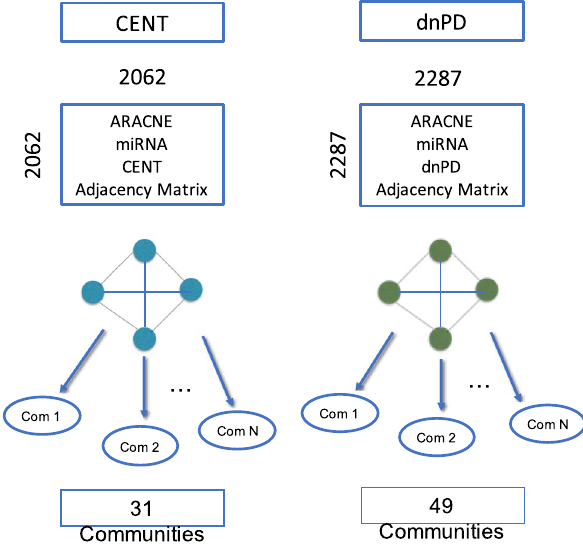
Figure 2. Network analysis. Graphical process of the network analysis implemented for the two cohorts of dnPDs and CENT. Nodes per community are listed by the adjacency matrix box, and the final numbers of communities are shown below each cohort. The figure was created using PowerPoint software Version 16.30, 2019, (https:// www. micro soft.